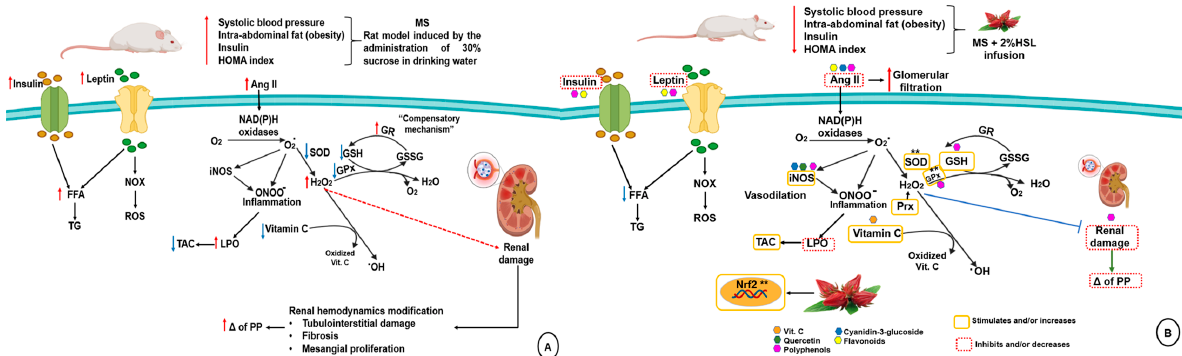
Figure 7. Panel ( A ) renal damage in metabolic syndrome on the alteration of the enzymatic and non-enzymatic antioxidant systems. Panel ( B ) Effect of 2% HSL infusion on enzymatic and non-enzymatic antioxidant systems in kidney of the MS rats. Abbreviations: FFA = free fatty acids, H 2 O 2 = hydrogen peroxide, HSL = Hibiscus sabdariffa L., GPx =glutathione peroxidase, GR = glutathione reductase, GSH = glutathione, GSSG = oxidized glutathione, LPO = lipoperoxidation, MS = metabolic syndrome NOX = nicotinamide adenine dinucleotide phosphate oxidase, i NOS = inducible nitric oxide, O 2 − = superoxide anion, OH = hydroxyl radical, ONOO − = peroxynitrate, Prx = peroxidases, ROS = reactive oxygen species, SOD = superoxide dismutase, TAC = total antioxidant capacity, TG =